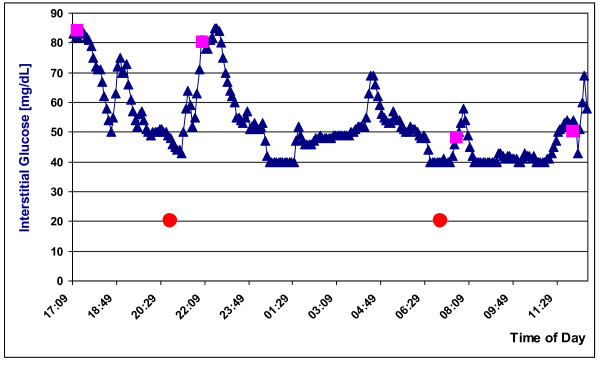
Real time glucose monitoring (RTGM) in a normoglycemic GMP over ca. 20 h; squares: conventional skin puncture blood glucose measurements; circles: feeding with standard dry feed.